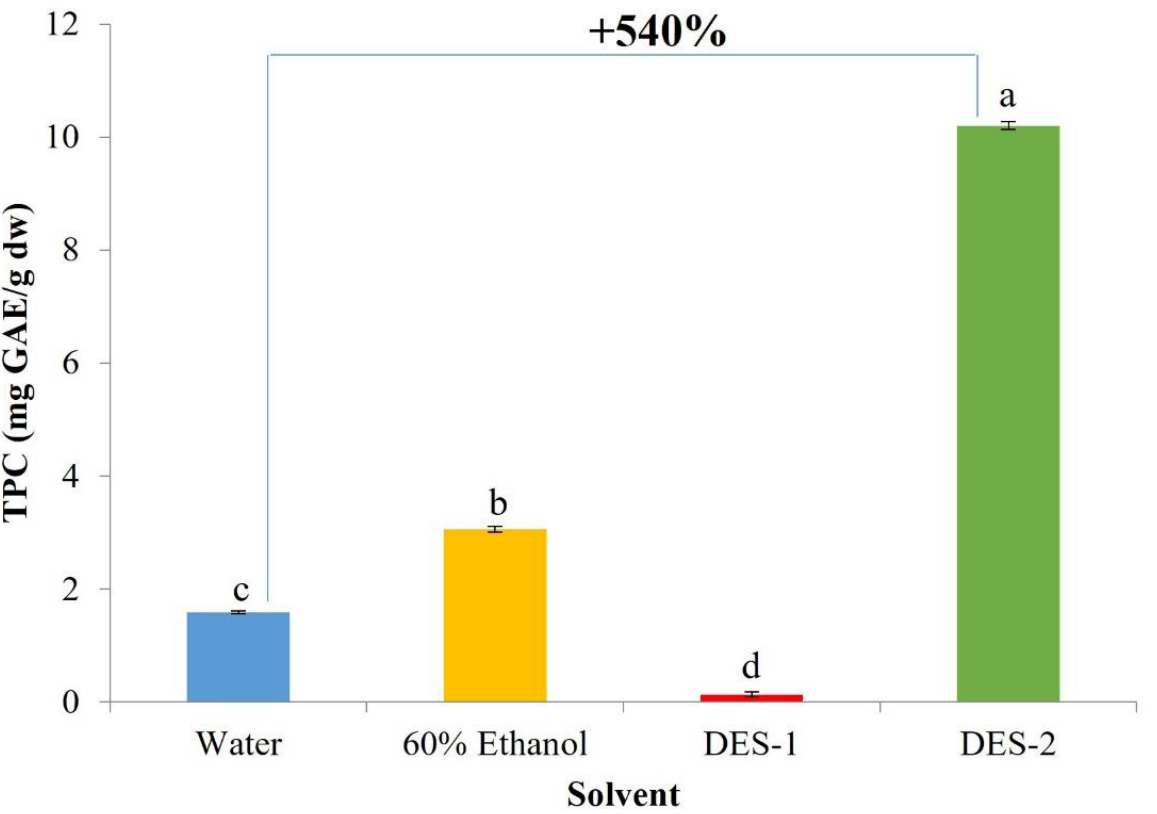
Figure 1. Total polyphenol content (TPC, mg GAE/g dw) of the extracts from APW using different solvents; Standard deviation is presented with error bars and means with different superscript letters are significantly ( p < 0.05) different.